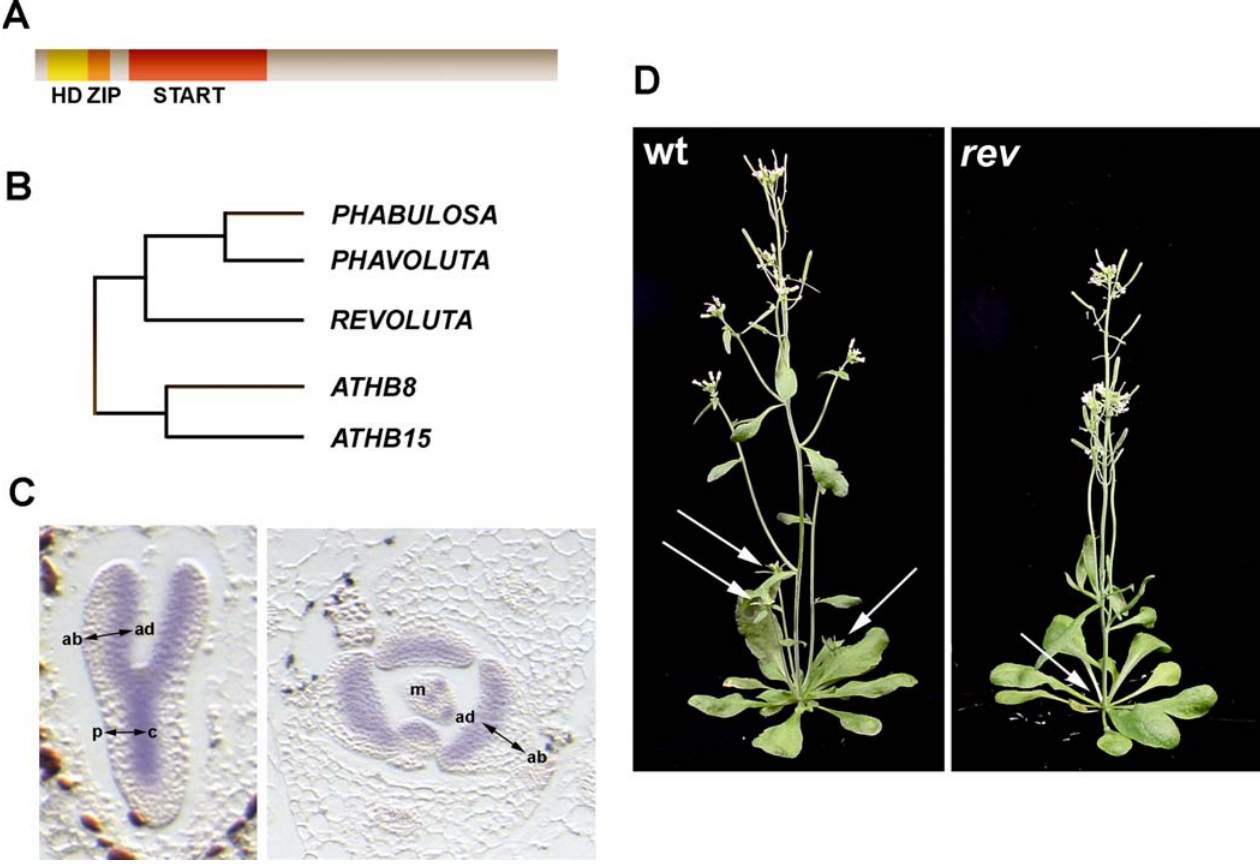
Figure 2. Class III HD–ZIP Genes in Arabidopsis (A) Class III HD–ZIP genes encode 833–852 amino acid proteins with main domains indicated; an N-terminal HD-ZIP domain, and a 213–218 amino acid START domain. (B) Relationship between five Arabidopsis Class III HD–ZIP genes. (C) Representation of expression pattern of PHB in longitudinal section of embryo (left) and transverse section of shoot apex (right). In the embryo, expression is adaxial in cotyledons and in central provasculature. In the shoot apex, expression is adaxial in developing leaves and in the meristem. ad, adaxial; ab, abaxial; p, peripheral; c, central; m, meristem (D) Phenotype of rev mutants. In wild-type, axillary meristems in axils of leaves give rise to lateral branches (arrows). In rev mutants, axillary meristems are frequently absent, and fewer or no lateral shoots are produced.